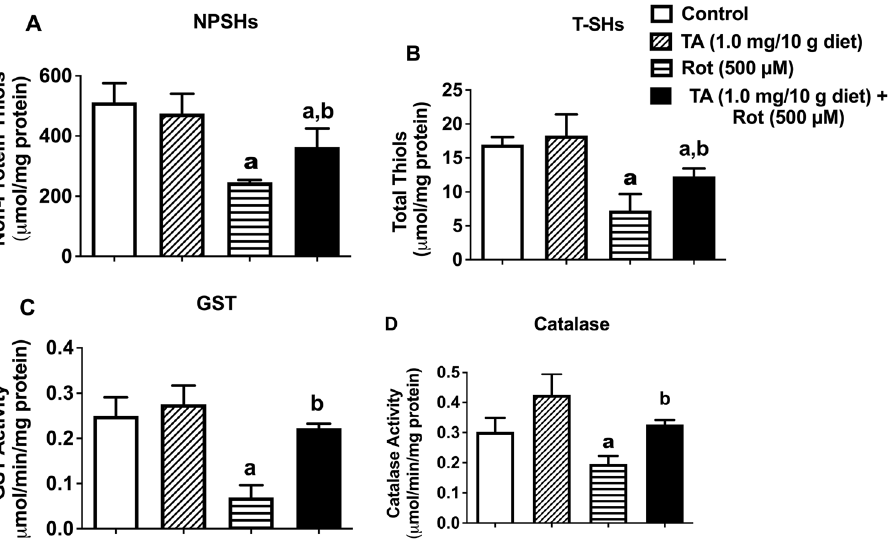
Figure 4. Effects of TA (1.0 mg/10 g diet) and/or rotenone (500 μM) on Levels of NPSHs ( A ), T-SHs ( B ), and activities of the enzymes GST ( C ) and Catalase ( D ). Data in ( A – D ) are presented as Mean ± SEM of 50 flies per vial (five replicates per group). a: Significant difference compared with control group; b: Significant difference compared with rotenone group (p < 0.05). TA trans-astaxanthin, NPSHs non-protein thiols, T-SHs total thiols, GST